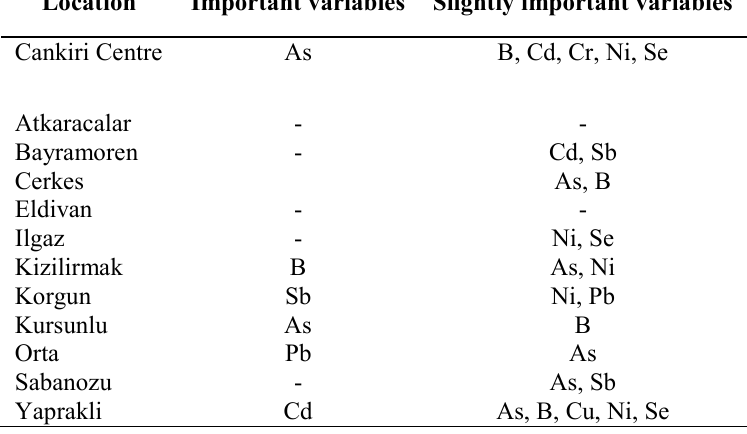
Table 3. The most important water quality variables for each location of Cankiri, Turkey.